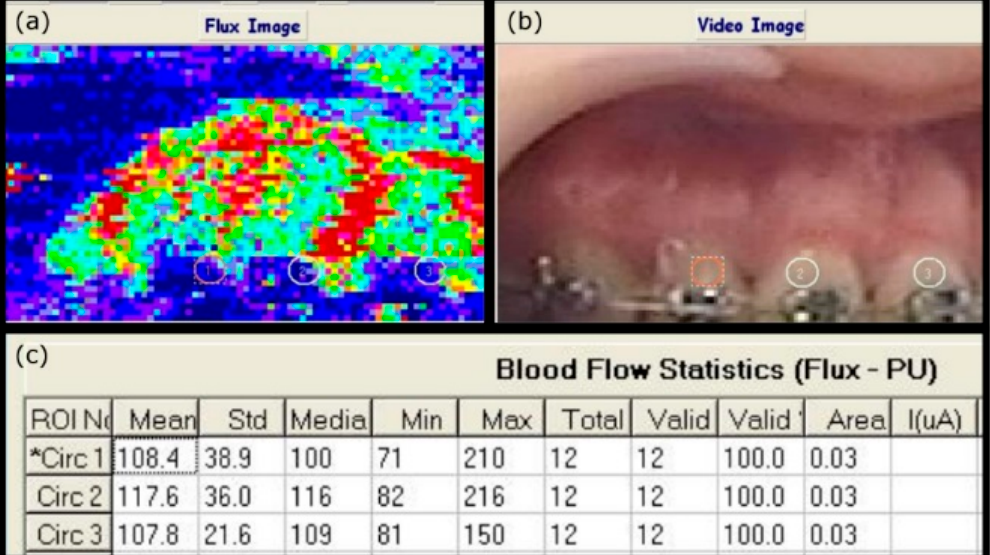
Figure 5. Laser Doppler to track the pulp vitality. ( a ) In the flux image, the red color represents areas of abundant blood flow, corresponding to the video image ( b ), in which the red circle shows the tooth to be measured. According to ( c ), PU analysis of laser Doppler revealed that circle 1 was the red circle (* means the circle 1 was selected as the reference). The calculated perfusion units in the diseased tooth were not significantly different from those in the two control teeth, indicating that the tooth remained viable. Continuous follow-up was recommended.